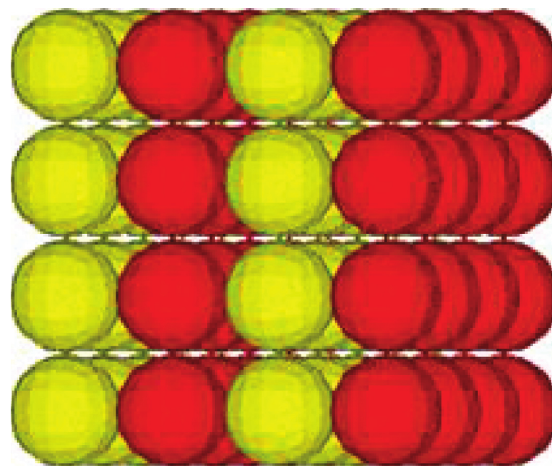
Figure 8: Simple cubic packed particles.